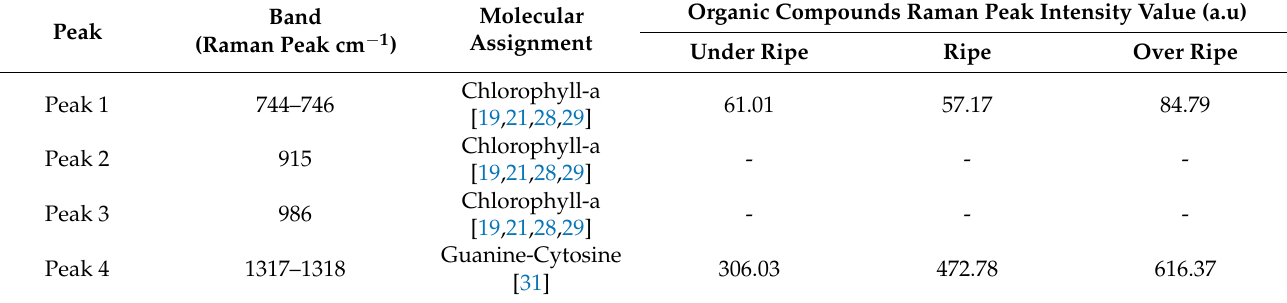
Table 3. Summary of Raman bands and their molecular assignments with intensity values for three oil palm fruit ripening classes for sample B without spectrum oil palm fruit ripening classes for sample B without spectrum pre-processing.